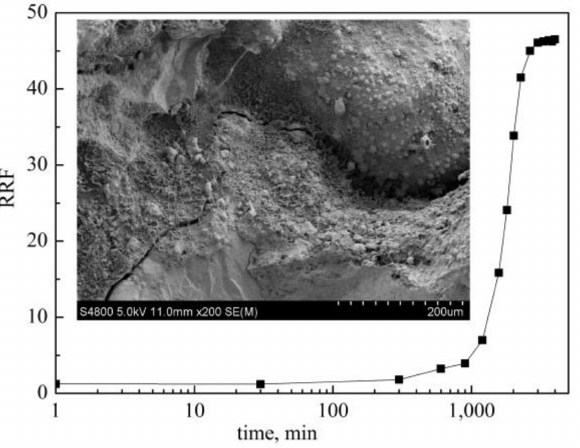
Figure 2. The curve of RRF vs. time under static gelation in porous